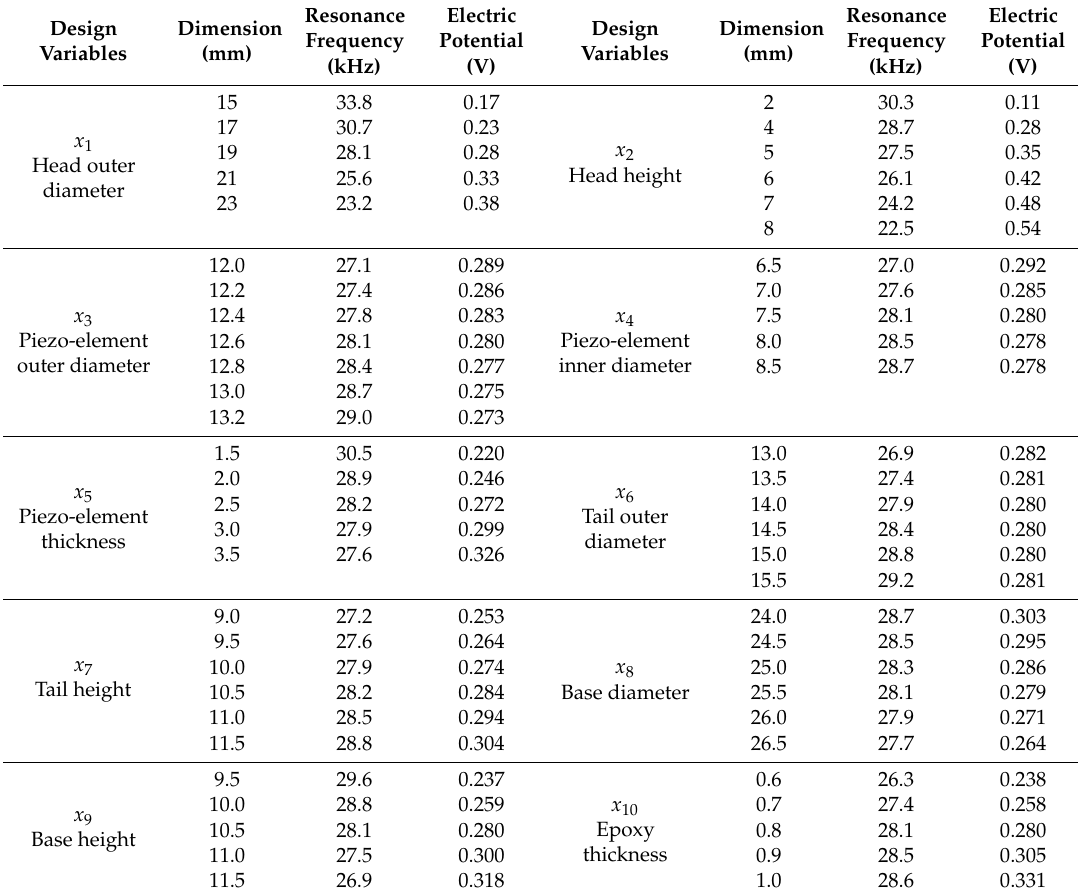
Table 4. Resonance frequency and electric potential calculated with the change of design variables x 1 through x 10 using the obtained Kriging